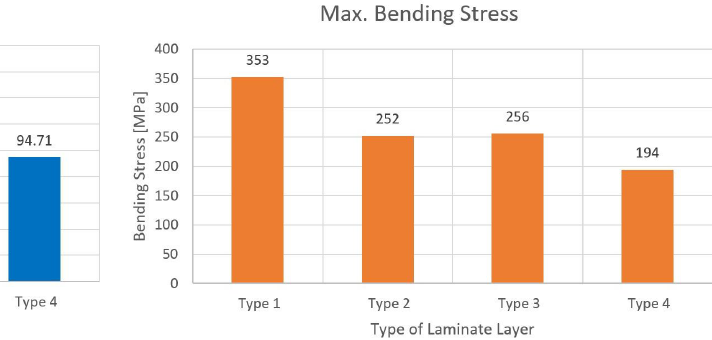
Figure 9: Maximum bending load of HCGFRP in each laminate Figure 10: Maximum bending stress of HCGFRP in each laminate configuration